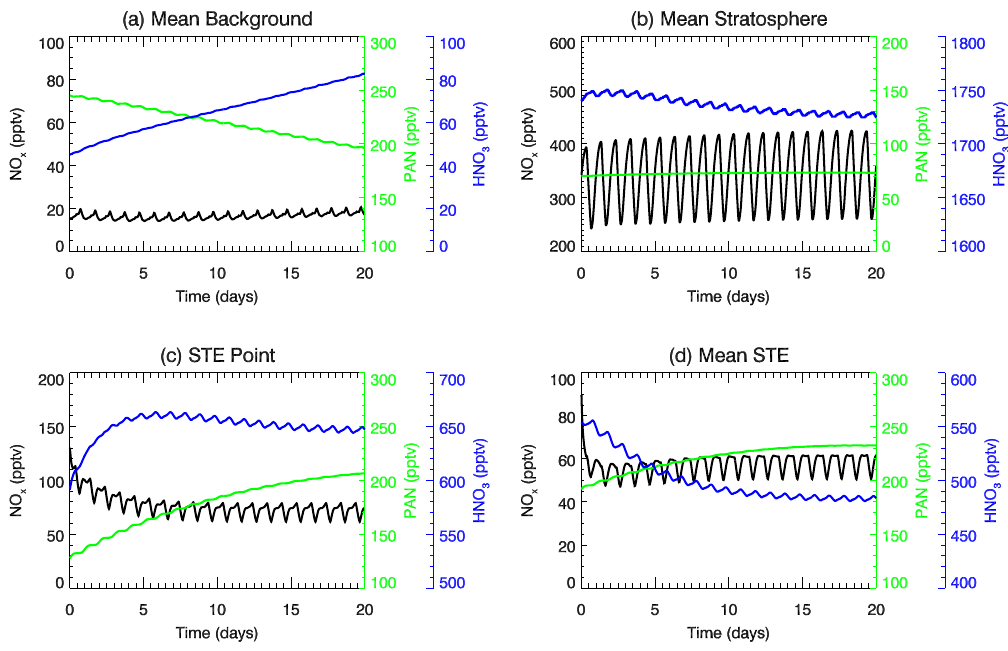
Fig. 9. Time-dependent box-model calculation of NO x , PAN, and HNO 3 partitioning in (a) mean upper tropospheric background and (b) mean lower stratospheric air. We also show results from a third box-model calculation aiming to simulate the stratosphere-troposphere mixed subplume A sampled by the July 8 flight (c) . We assume injection of the lower stratospheric air into the background air mass with a mixture ratio of 30% stratospheric air vs. 70% background air which yields approximately the measured CO and CH 4 in the stratosphere-troposphere mixed plume. (d) shows what happens in a more generalized stratosphere-troposphere mixed case assuming 30% stratospheric air mixes with 70% tropospheric air using the measured mean concentrations in the two air masses during